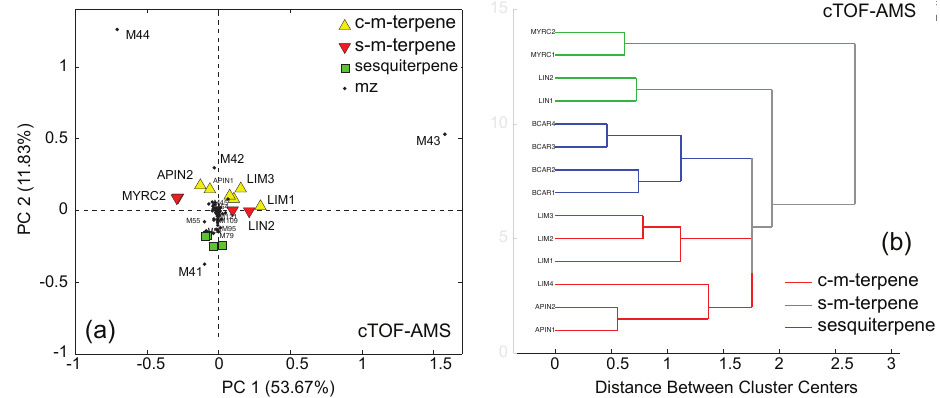
Figure 8. (a) Loadings bi-plot of the second vs. first principal components obtained from the PCA of cTOF-AMS aerosol spectra from of a subset of terpene experiments and (b) the corresponding HCA dendrogram. See main text (Sect. 4.5 and Table 3) for further information, including ion